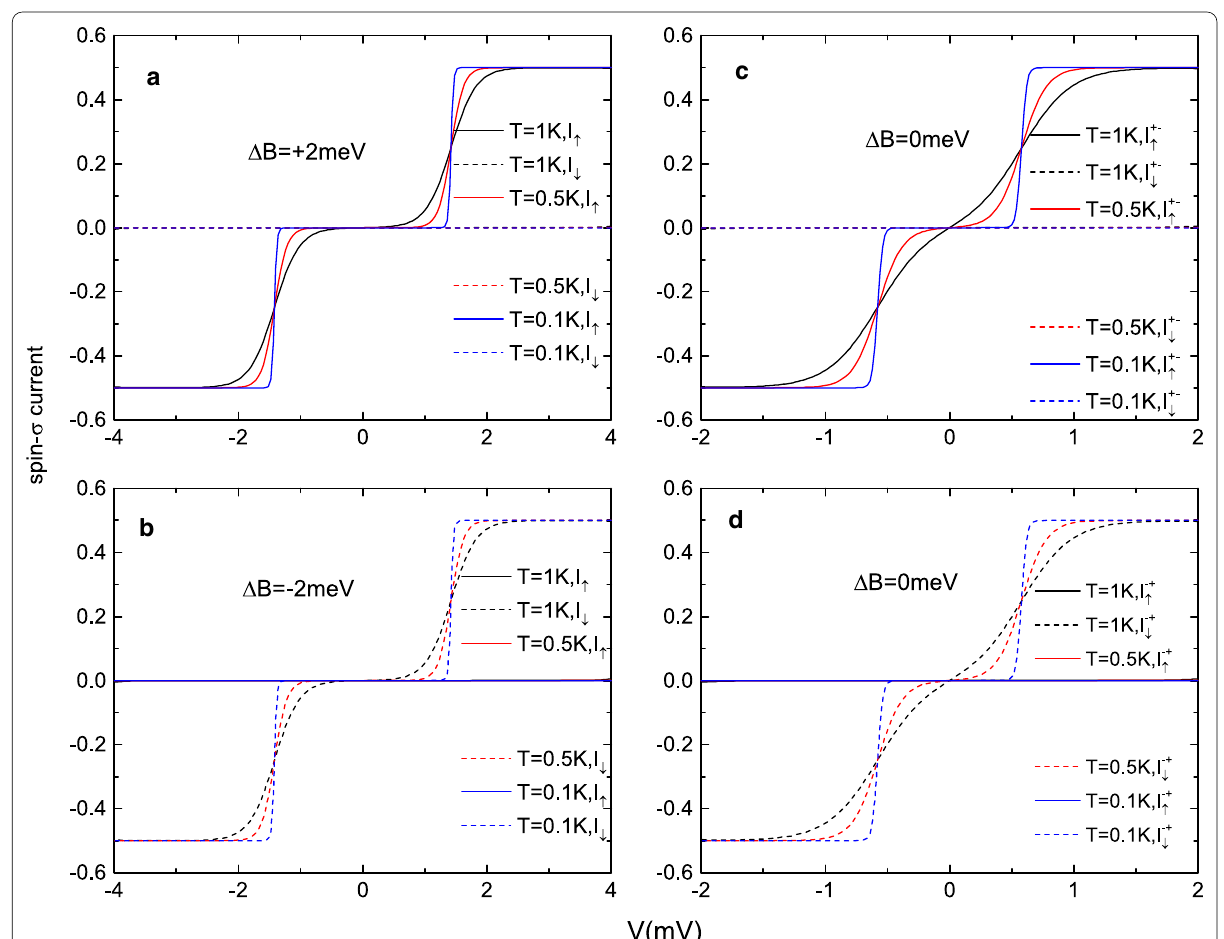
Fig. 3 Spin- σ currents I ↑ ( ↓ ) (scaled by e Ŵ 0 / (cid:31) ) ( a , b ) in the presence of external magnetic fields of a (cid:31) B = + 2 meV, b (cid:31) B = − 2 meV, c , d in the absence of a magnetic field as functions of the bias